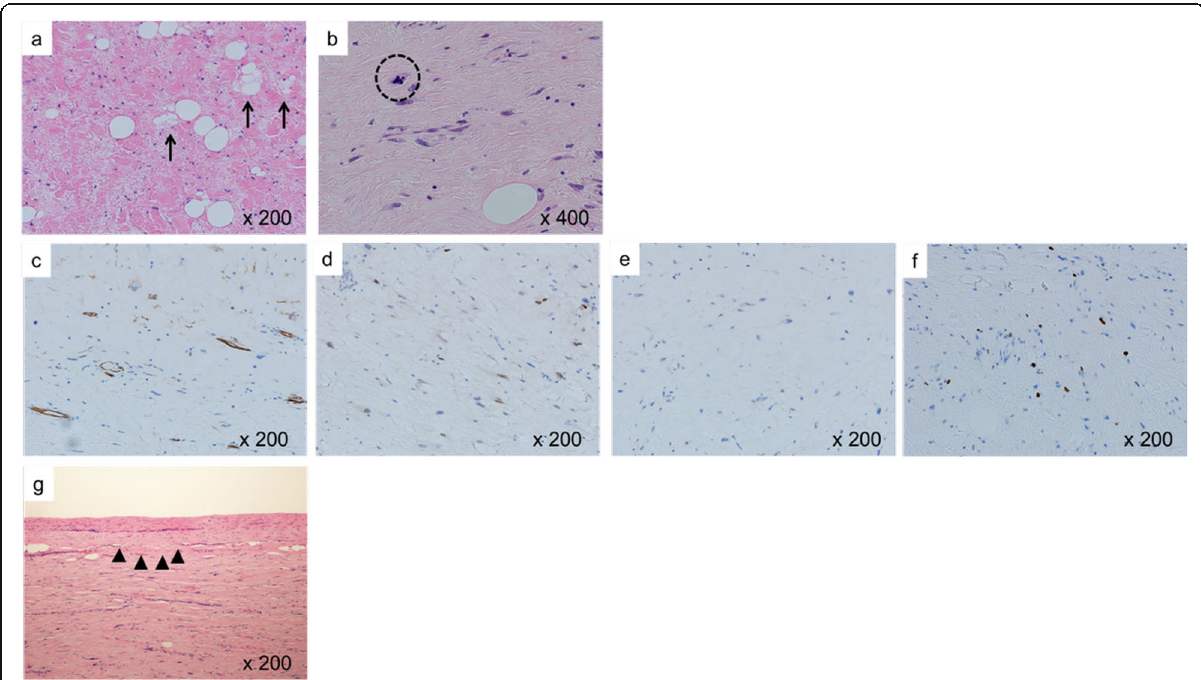
Fig. 3 The figure shows a few lipoblasts ( a : arrows) and mitosis ( b : dotted circle). Immunohistochemistry shows positivity for CD34 ( c ) and mouse double minute 2 (MDM2) homolog ( d ), and negativity for signal transducers and activator of transcription 6 (STAT6) ( e ). There is positivity for Ki- 67, and the MIB-1 index is up to 10% ( f ). The tumor has partially invaded the pericardium ( g :